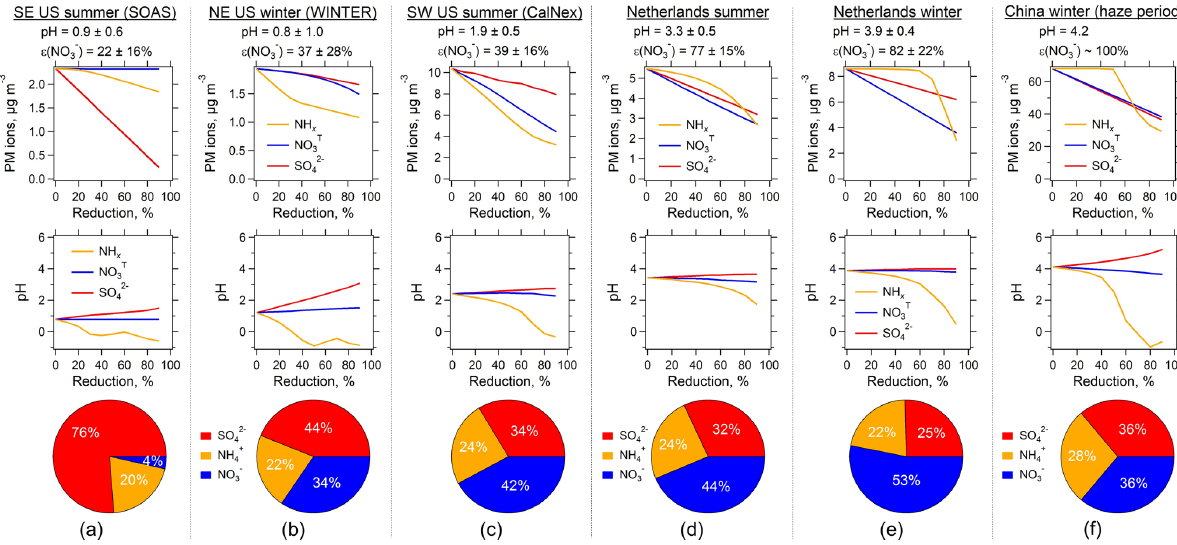
Figure 5. Response of predicted PM 2 . 5 inorganic mass concentration (first row) and pH (second row) to reduced levels of NH x (NH 3 + NH + ), NO T (HNO 3 + NO − ), and SO 2 − for several studies including (a) the southeastern US summer at a rural ground site in 4 3 3 4 Centreville, AL (SOAS study); (b) the northeastern US during winter (WINTER aircraft study); (c) the southwestern US summer at an urban site in Pasadena, CA (CalNex study); (d, e) the Netherlands summer and winter conditions at a rural site in Cabauw from this study; and (f) polluted winter conditions (haze) in Beijing, China. For each case, the average fine ambient particle pH and ε (NO − tions, are shown above the figures, with the columns ordered with increasing ambient particle pH from left to right. PM 2 . 5 mass fractions of NH + –SO 2 − –NO − based on study averages are shown as pie graphs along the 4 4 3